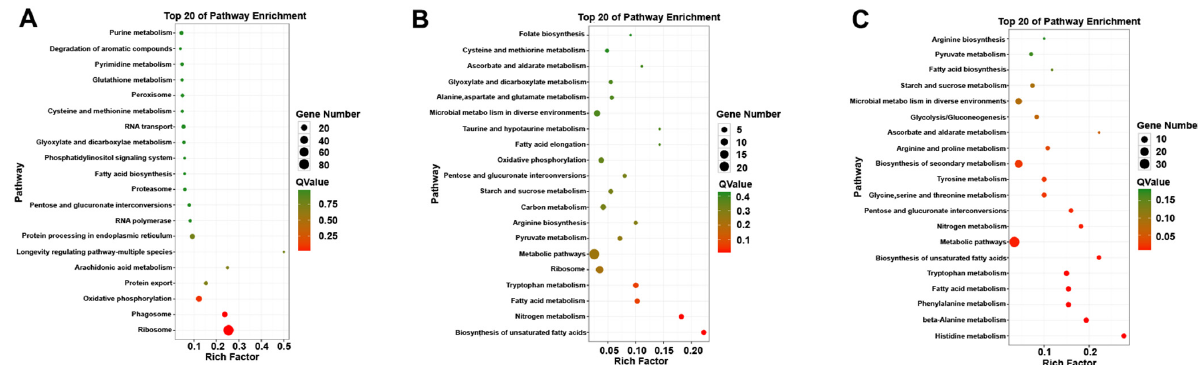
Figure 6. Summary of the KEGG enrichment map of different genes under different treatment conditions. ( A ) CK vs. T1; ( B ) CK vs. T2; ( C ) T1 vs. T2. Note: The size of the circle represents the number of differentially expressed genes KEGG enrichment map. The larger the circle, the more differentially expressed genes enriched in this pathway.